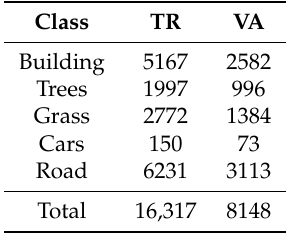
Table 1. Vaihingen scene: classes, training and validation samples.